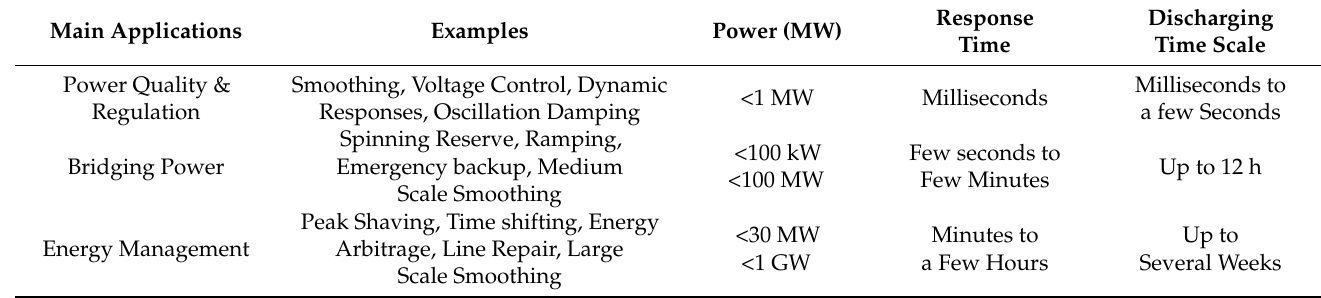
Table 1. Different applications of EES technologies and their main associated features [3,4].